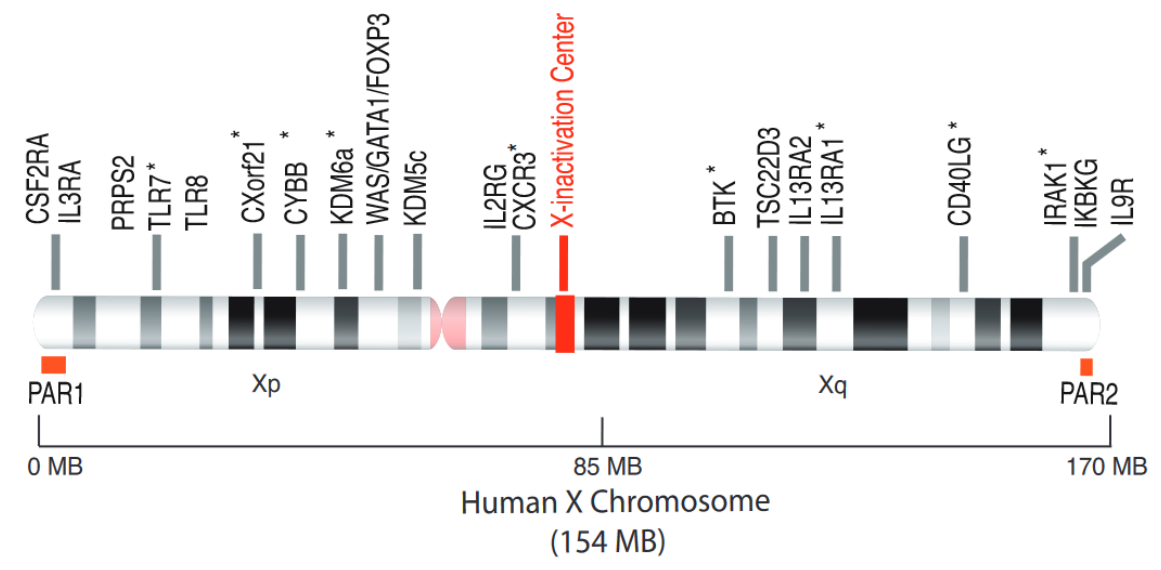
Figure 2. The human X chromosome and the escapee genes from XCI. The human X chromosome, 154 MB in size, codes for around 1100 genes, many of which are involved in immune responses ( WAS, BTK, FOXP3, IL2RG ). The TLR7 gene, located on the short arm of the X chromosome, is able to escape from XCI. The other genes whose escape has been clearly demonstrated, are annotated with an asterisk (*) and described in the Table 1. PAR1, pseudoautosamal region 1; PAR2, pseudoautosomal region 2.